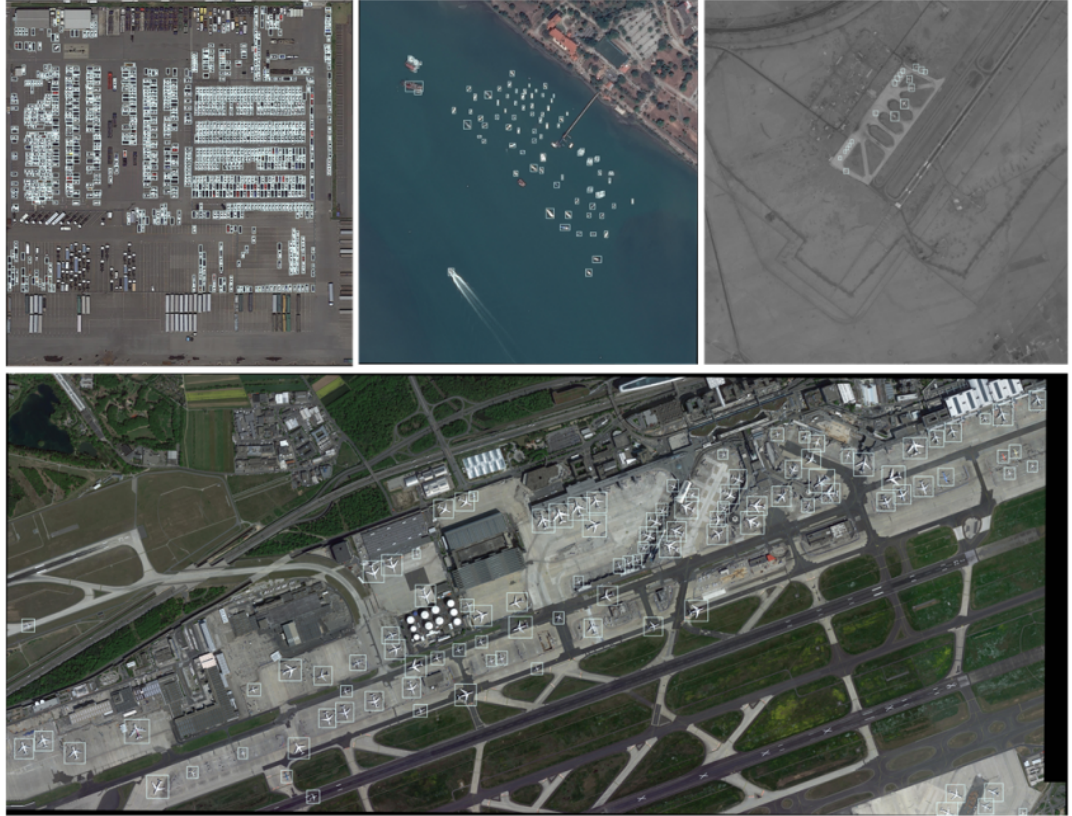
Figure 1. Examples difficult to detect. Objects in remote sensing images are not only very small and densely clustered but also arranged with diverse orientations and extremely complex